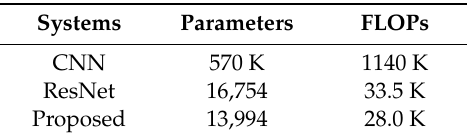
Table 9. Summary of the number of parameters and the number of the floating point operations (FLOPs) used in the